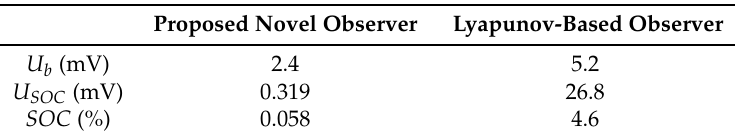
Table 2. The estimation errors (RMSEs) comparison between the proposed novel observer and the Lyapunov-based observer